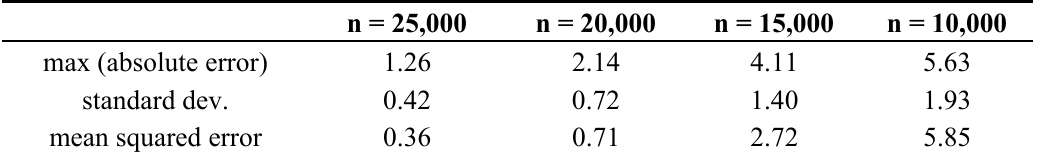
Table 7. Results for Expert 3 with n = 25,000; n = 20,000; n = 15,000 and n = 10,000. n = 25,000 n = 20,000 n = 15,000 n = 10,000 max (absolute error) 1.64 standard